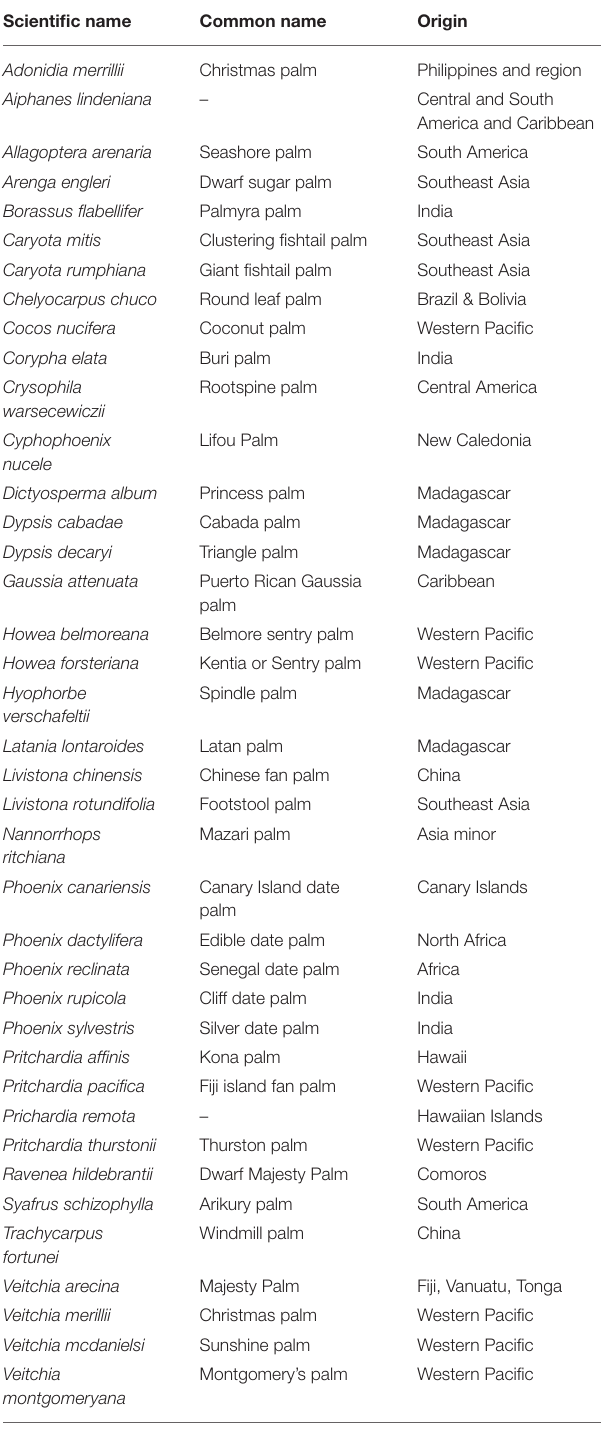
TABLE 2 | List of palm species in Florida known to be susceptible to LYD (16SrIV-A) from Harrison et al. (1999) and Howard